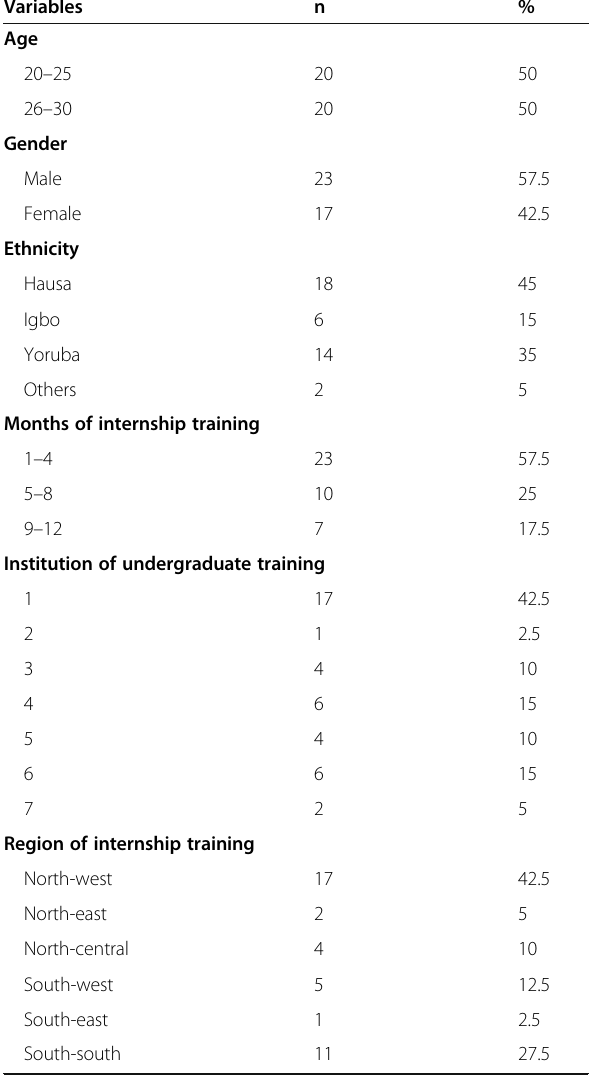
Table 1 The socio-demographic variables of the study